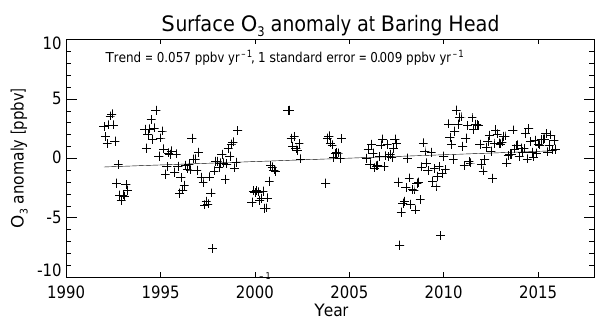
Figure 5. Observed monthly mean surface O 3 anomaly and the cor- responding linear trend at Baring Head